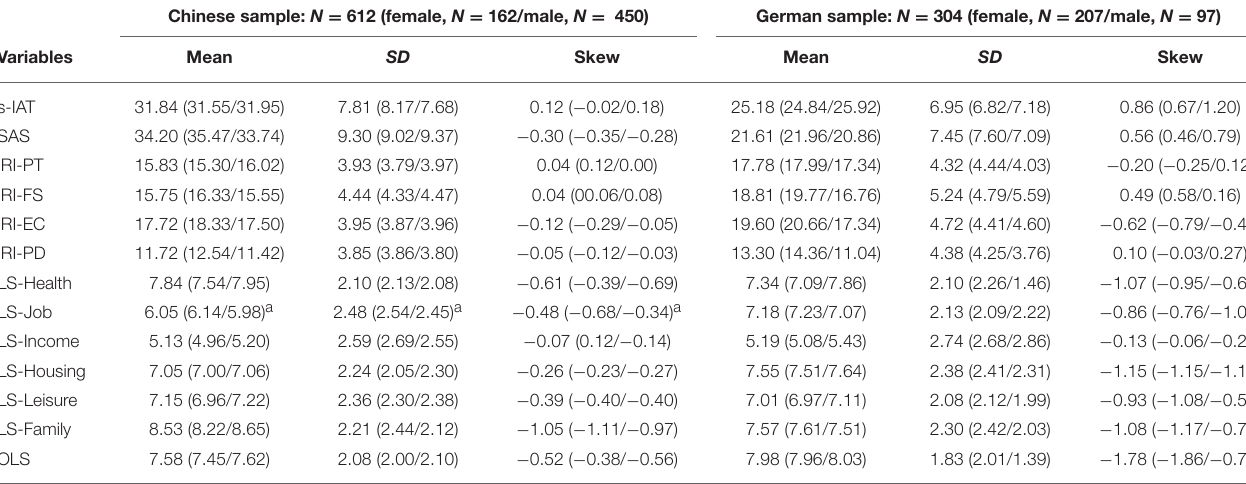
TABLE 1 | Descriptive statistics for digital use variables (s-IAT, SAS), IRI empathy, and life satisfaction variables. Chinese sample: N = 612 (female, N = 162/male, N =